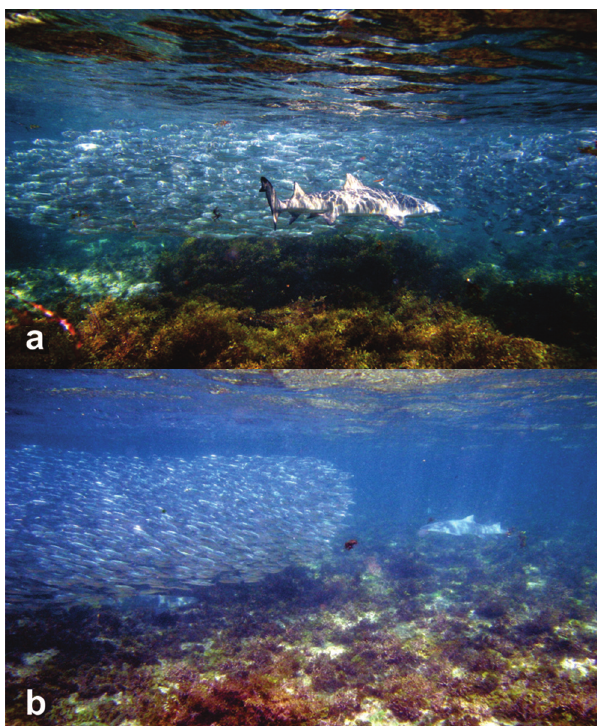
Fig. 3. a. and b. Juvenile Negaprion brevirostris in site 1 seconds before striking a school of sardines.